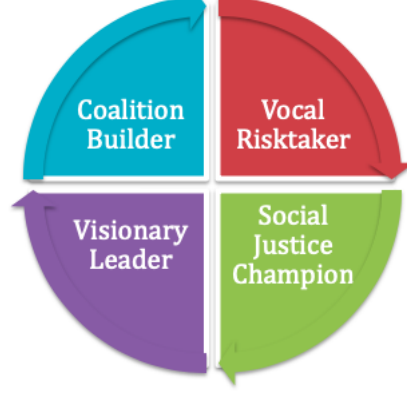
Figure 1. The Single Profile Model